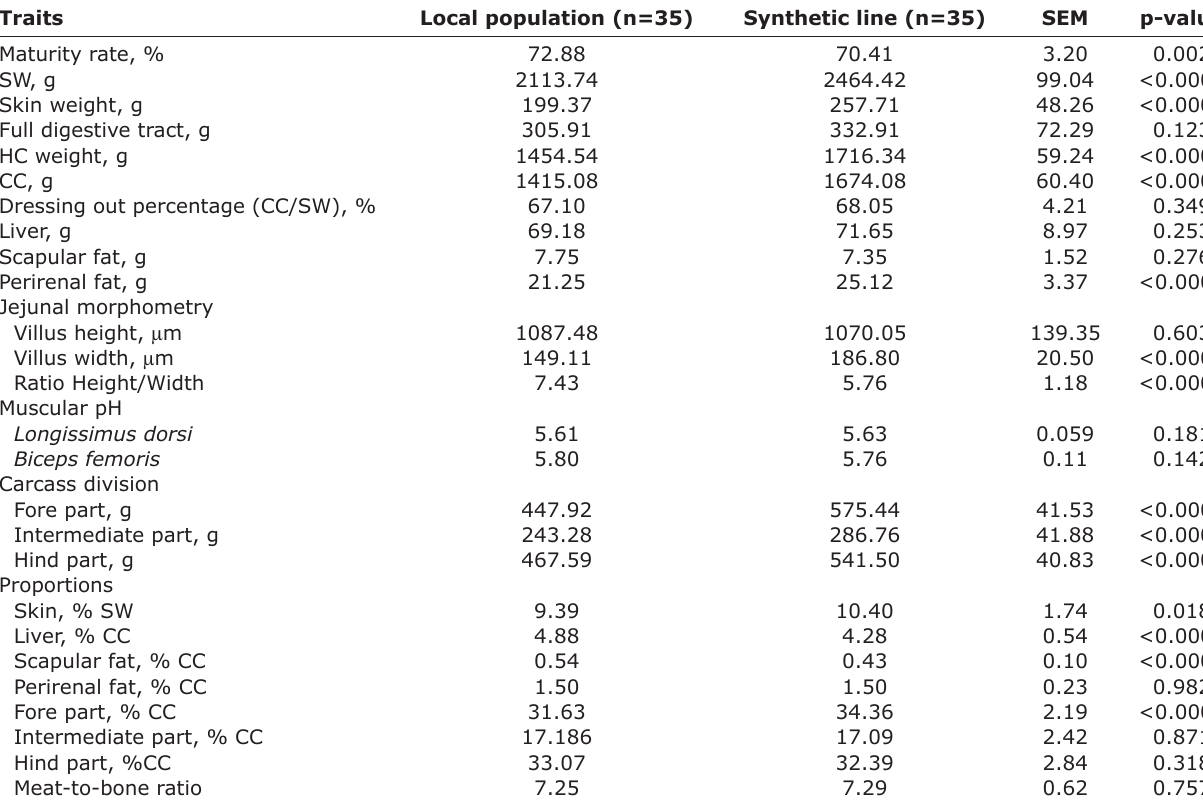
Table-3: Slaughter data, carcass traits, and jejunum morphometry in the local population and the synthetic line. Traits